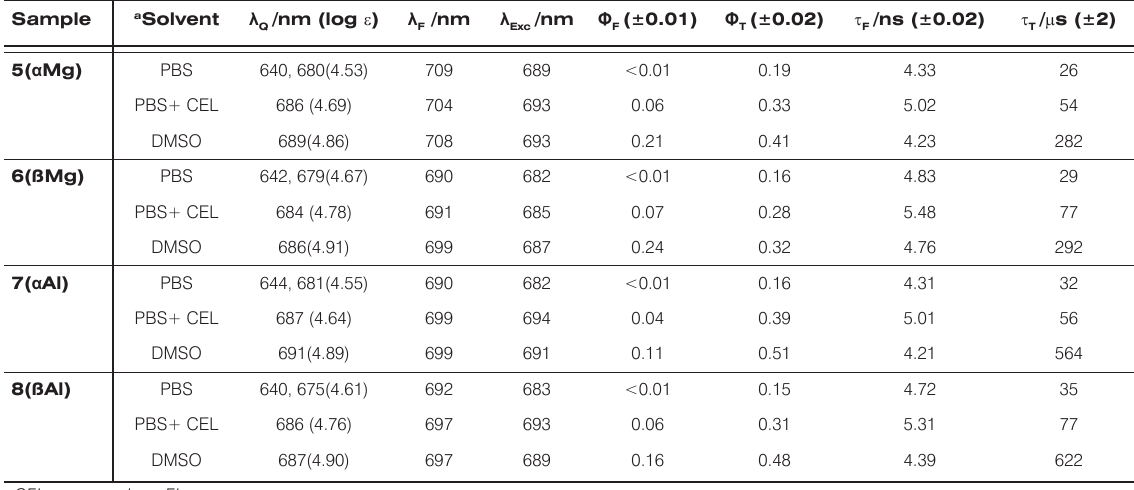
Table 1. Spectral and photophysical parameters of phthalocyanine derivatives in aqueous and non-aqueous media.